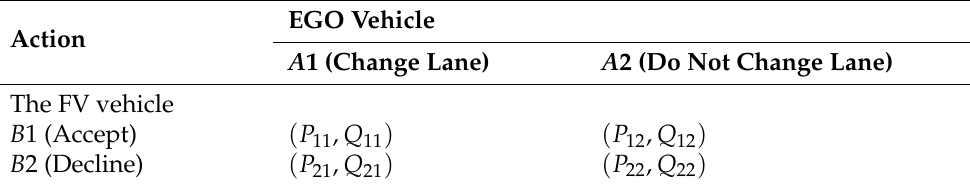
Table 1. Dynamic noncooperative game description in its normal-form representation. EGO and FV denote the players; A 1 and A 2, and B 1 and B 2 denote their respective sets of strategies. Pxy and Qxy denote the outcome of the game, where x is the FV’s selected strategy and y is the strategy selected by EGO.